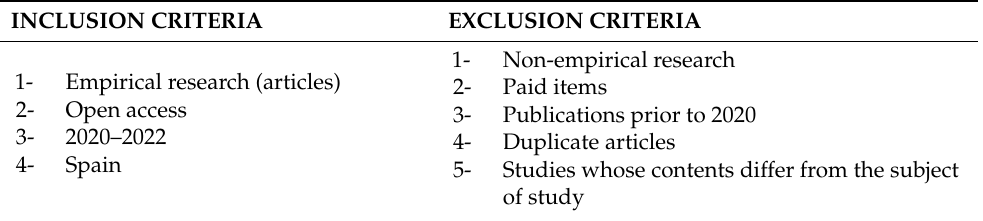
Table 2. Inclusion and exclusion